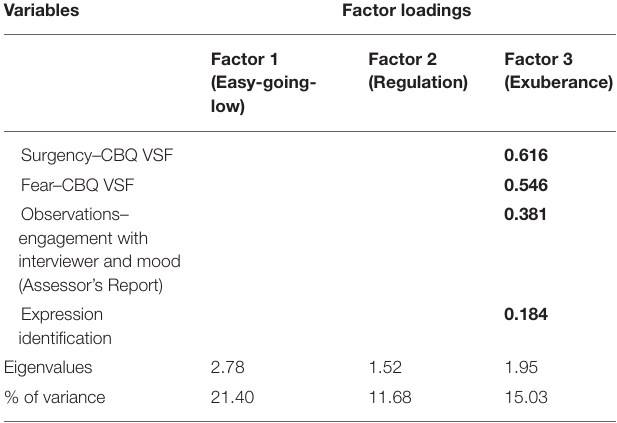
TABLE 1 | Summary of exploratory factor analysis results for variables at the three data collection